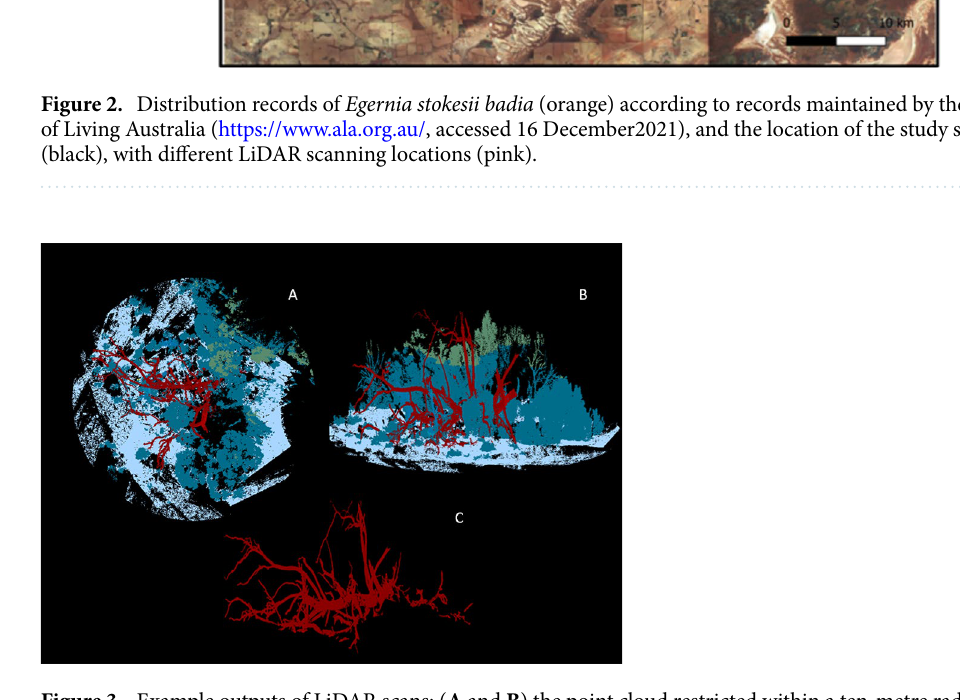
Figure 3. Example outputs of LiDAR scans; ( A and B ) the point cloud restricted within a ten-metre radius of the central log pile including the canopy cover (green), mid-storey cover (dark blue), and understorey (pale blue); and ( C ) the isolated log pile (red) from within the ten-metre radius point